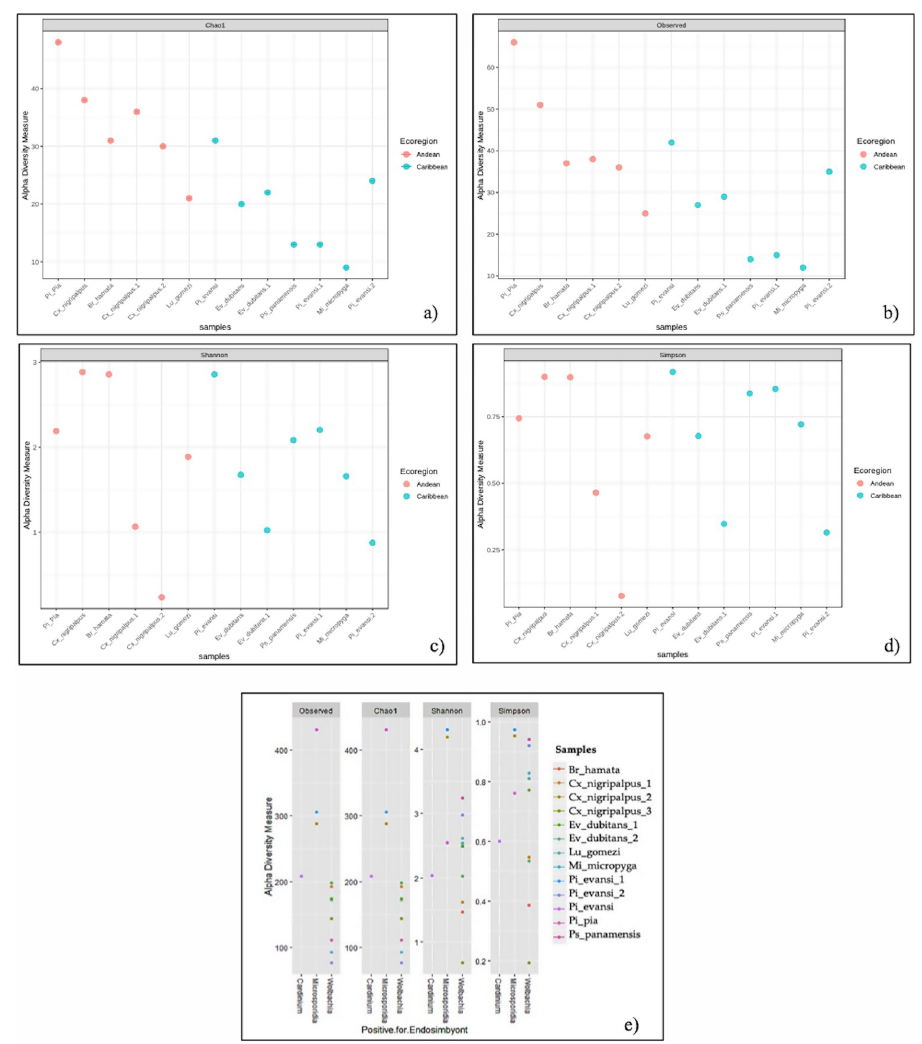
Fig 7. Alpha diversity (intra-diversity) of bacterial composition using amplicon sequence variants (ASVs) in sand flies and Cx . nigripalpus from Colombia by ecoregion and presence of endosymbiont. a) Species richness was assessed by Chao1 (estimates diversity from abundance data), b) Observed OTU (sum of unique OTUs in each sample), c) Shannon-Wiener (sum of species proportion logarithms) and d) Simpson indexes. e) Alpha diversity with all indexes but associated with the presence of endosymbionts. Higher index values indicate richer and more diverse bacterial